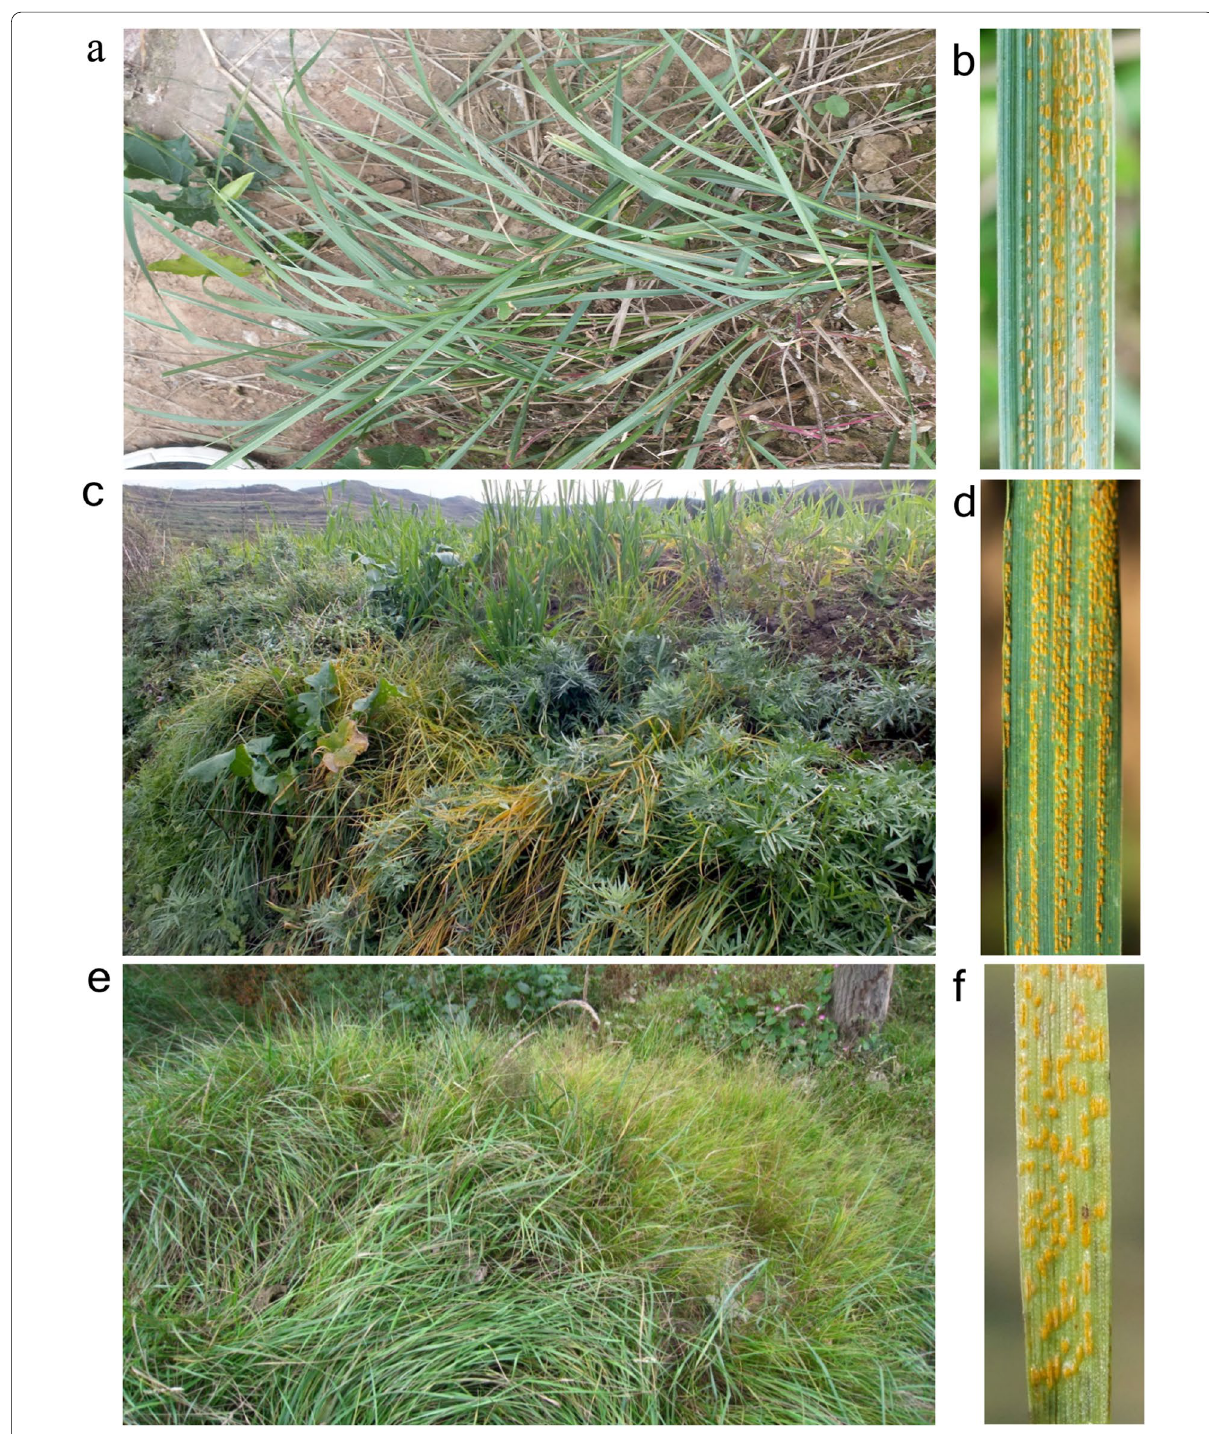
Fig. 1 Grass plants with stripe rust symptoms near crop fields in Tianshui, Gansu Province, China. a A. cristatum plants close to a rapeseed field in Pingnan, Tianshui (12 October, 2012). c E. cylindricus adjacent to a wheat field in Pingnan, Tianshui (2 October 2012). e E. excelsus near a corn field in Daimen, Tianshui (2 October 2012). b , d , f Close up images showing uredia on the grass leaves correspond to a, c and e ,